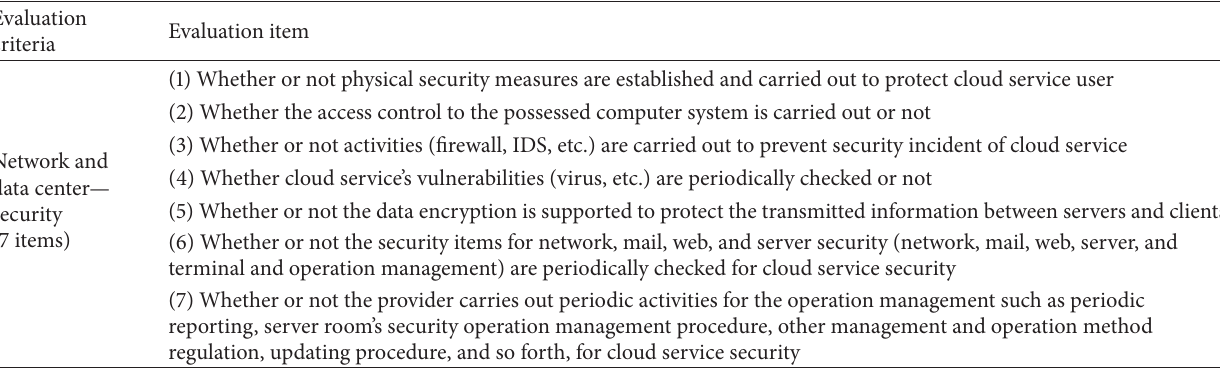
Table 12: Evaluation items of network and data center—security.